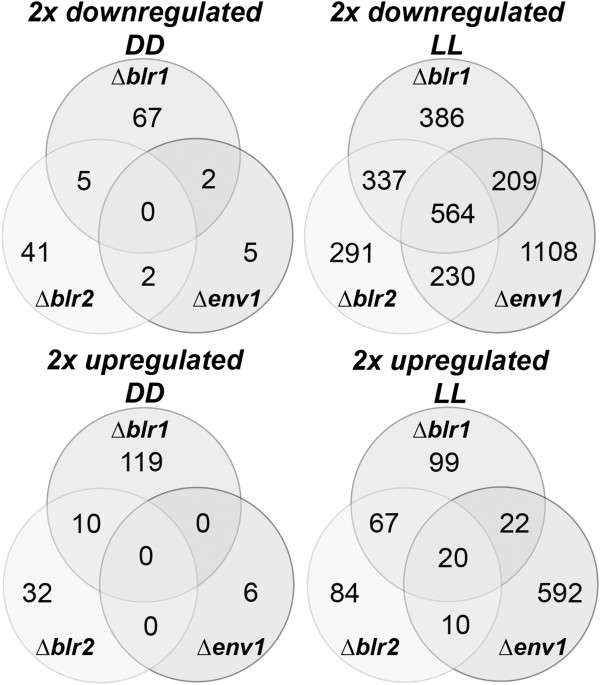
Overlap of target genes of ENV1, BLR1 and BLR2. The Venn-diagram shows twofold significantly regulated genes in the deletion strains ∆env1, ∆blr1 and ∆blr2 in comparison with the parental strain QM9414 in light and darkness.